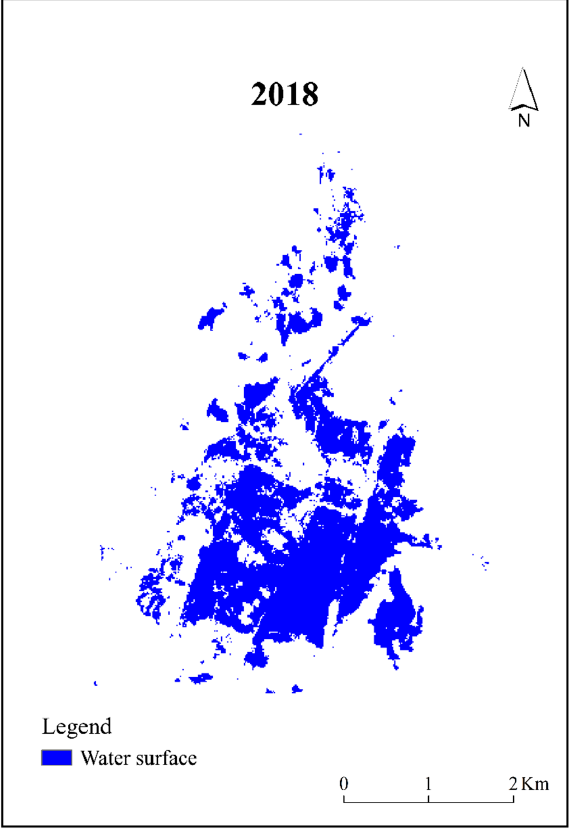
Figure 3. Water surface of Qingtu Lake in July 2018.